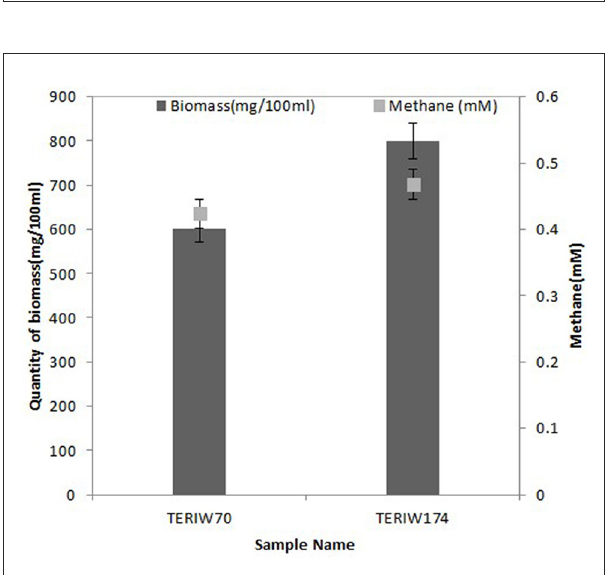
FIGURE5 Graph representation of microbial growth in terms of biomass and methane